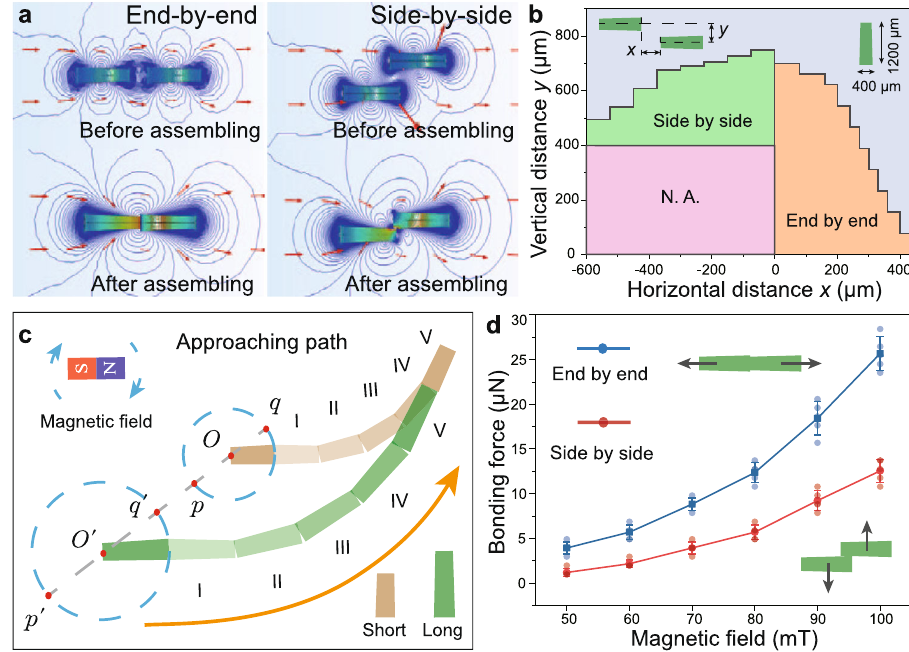
Fig. 2 Heterogeneous assembly between mCEBOT units. a Simulation results under magnetic fi eld, where the neighboring units connect by end-by-end or side-by-side according to their relative position and distance. b Distribution of connection states between two identical long units under 100 mT magnetic fi eld. c Heterogeneous assembly between short and long unit by taking advantage of their different step size. d Bonding force between two long units which connected by end-by-end and side-by-side respectively. Error bars indicate the standard deviation for n = 5 measurements at each data